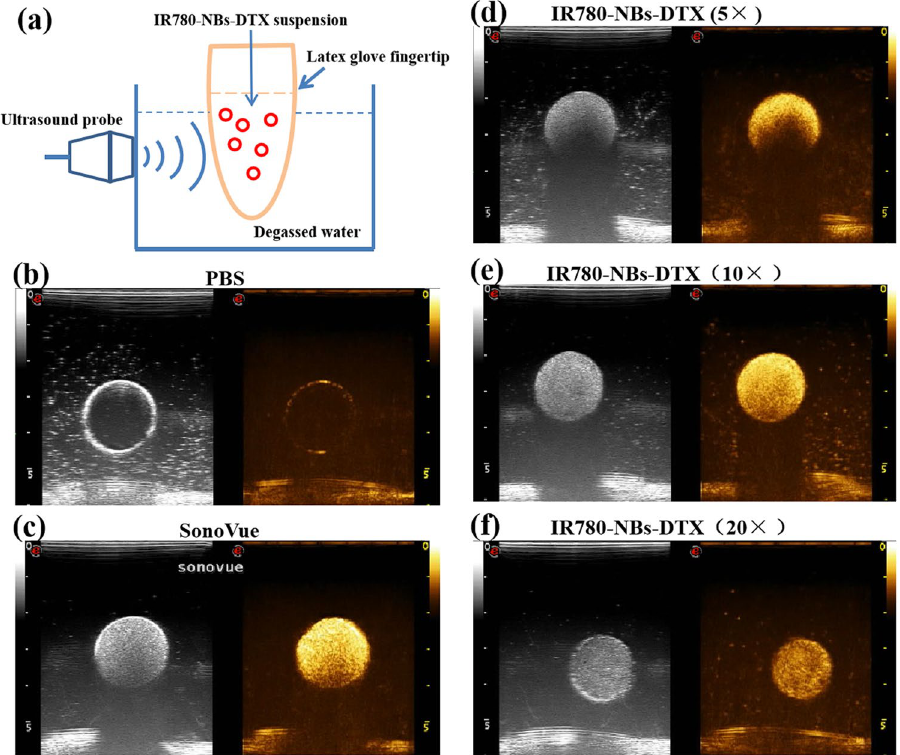
Figure 3. The CEUI of IR780-NBs-DTX in vitro. ( a ) Schematic illustration of the analytical setup for CEUI of IR780-NBs-DTX in vitro. ( b , c ) The CEUI of PBS and SonoVue as controls. ( d , e , f ) CEUI of different concentrations of IR780-NBs-DTX (×5: 1.2 × 10 7 bubbles/mL; ×10: 6 × 10 6 bubbles/mL; ×20: 3 × 10 6 bubbles/